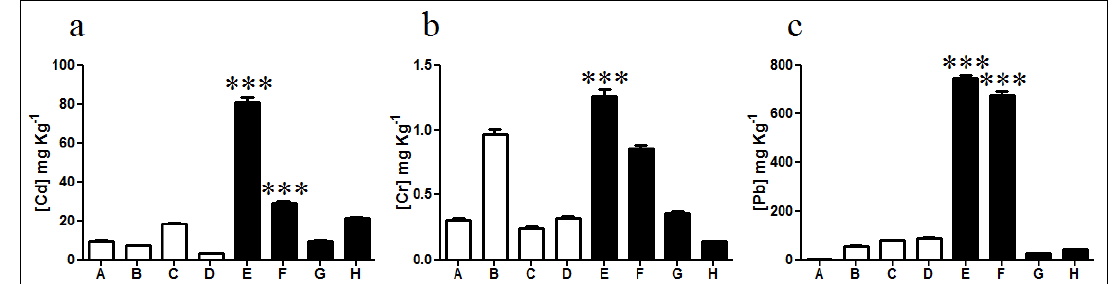
Figure 2. Quantification of heavy metals in soils. Concentration of ( a ) cadmium, ( b ) chromium, and ( c ) lead in non-exposed (white bars; A, B, C, and D) and diesel-exposed soil samples (black bars; E, F, G, and H). *** Represents significance with a p < 0.001.